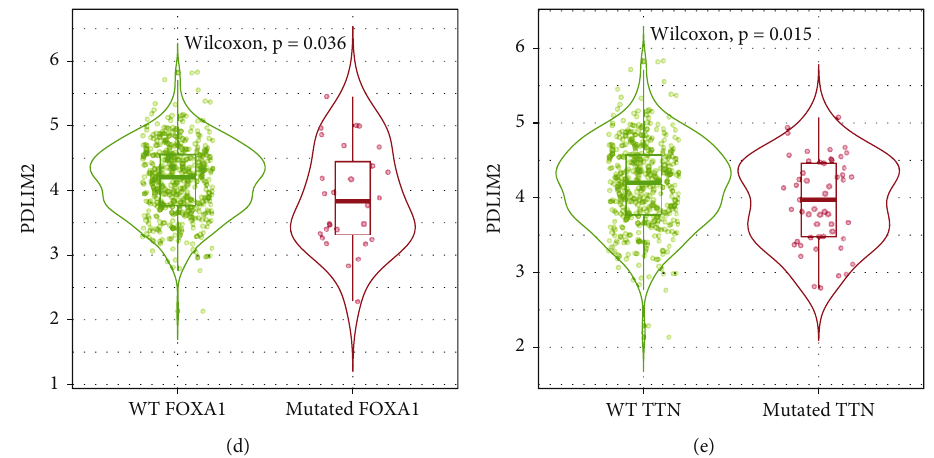
Figure 3: Correlation between PDLIM2 mRNA expression and mutation frequencies of prostate cancer-associated genes. (a) Gene mutation frequencies in TCGA-PRAD. (b) TMB scores of the high- and low-PDLIM2 groups using data from TCGA database. (c – e) Violin plots examining the e ff ect of PTEN, FOXA1, and TTN gene mutations on PDLIM2 mRNA expression in prostate